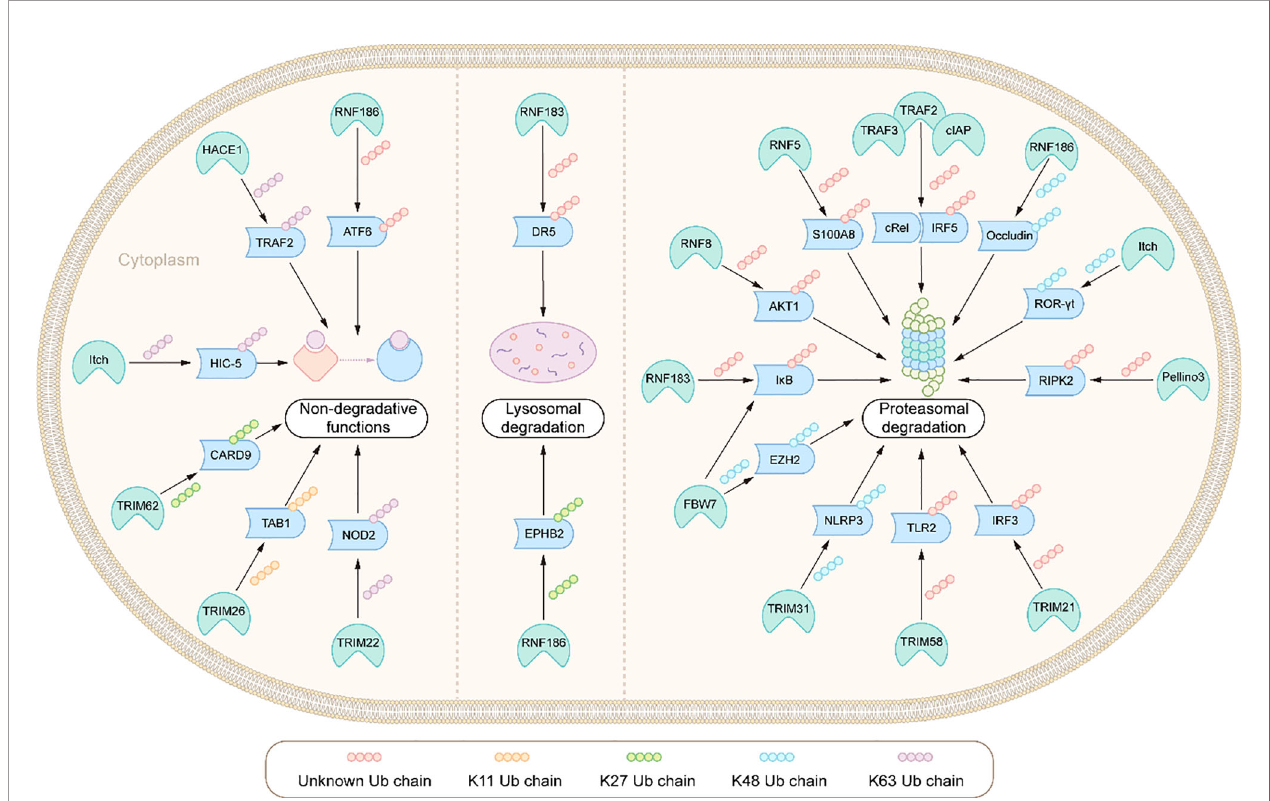
FIGURE 3 | Integration: E3s ligases and their ubiquitination modi fi ed substrates in the pathogenesis of